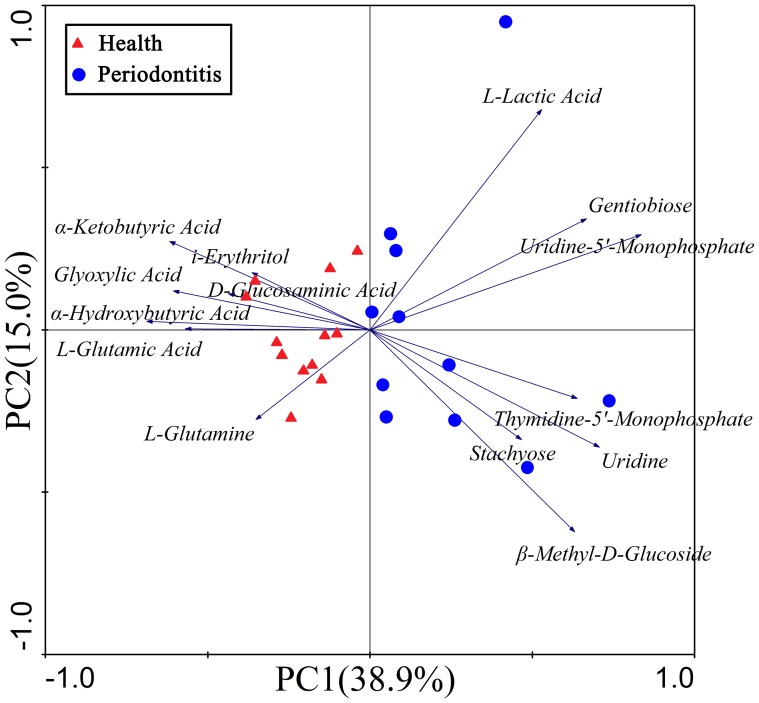
Ordination biplot of principal component analyses of the substrate utilization patterns of the microbial communities in the healthy and periodontitis groups using Biolog AN plate assays.Arrows indicate the directions and relative importance (arrow lengths) of the 14 substrates variables.